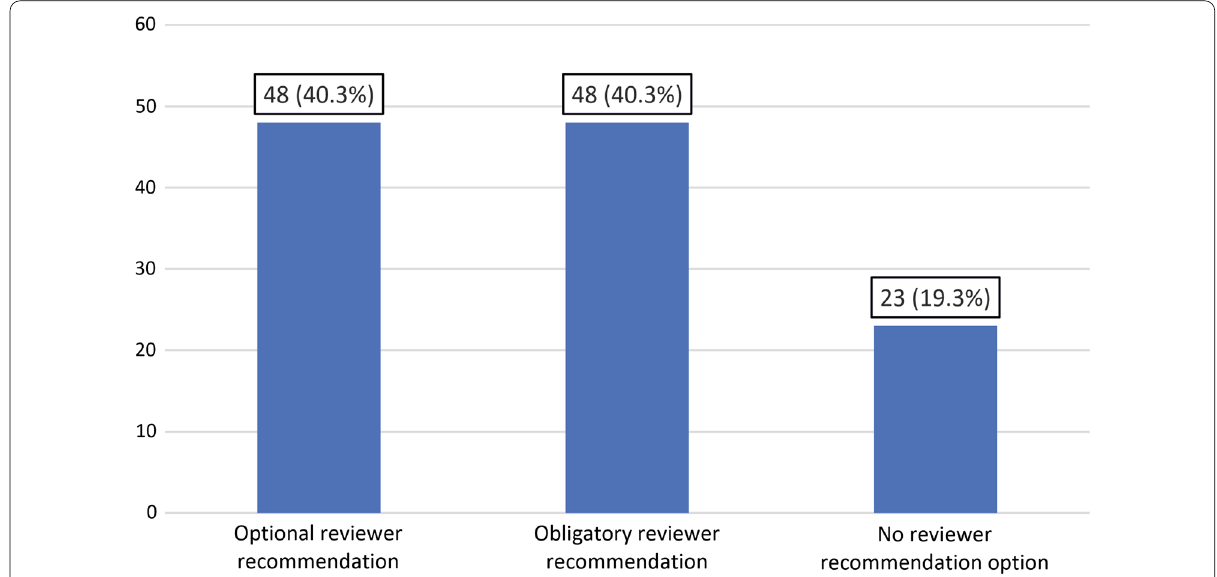
Fig. 3 Reviewer recommendation options by 119 medical imaging journals (absolute numbers with percentages between parentheses)